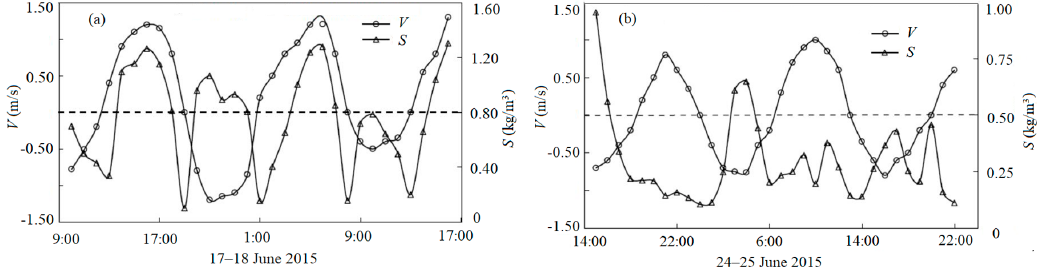
Figure 3. Station FS5 (FS6), mean flow velocity vs. mean sediment concentration ( V – S ) relationship for spring and neap tides: ( a ) Spring tide; ( b ) Neap tide.